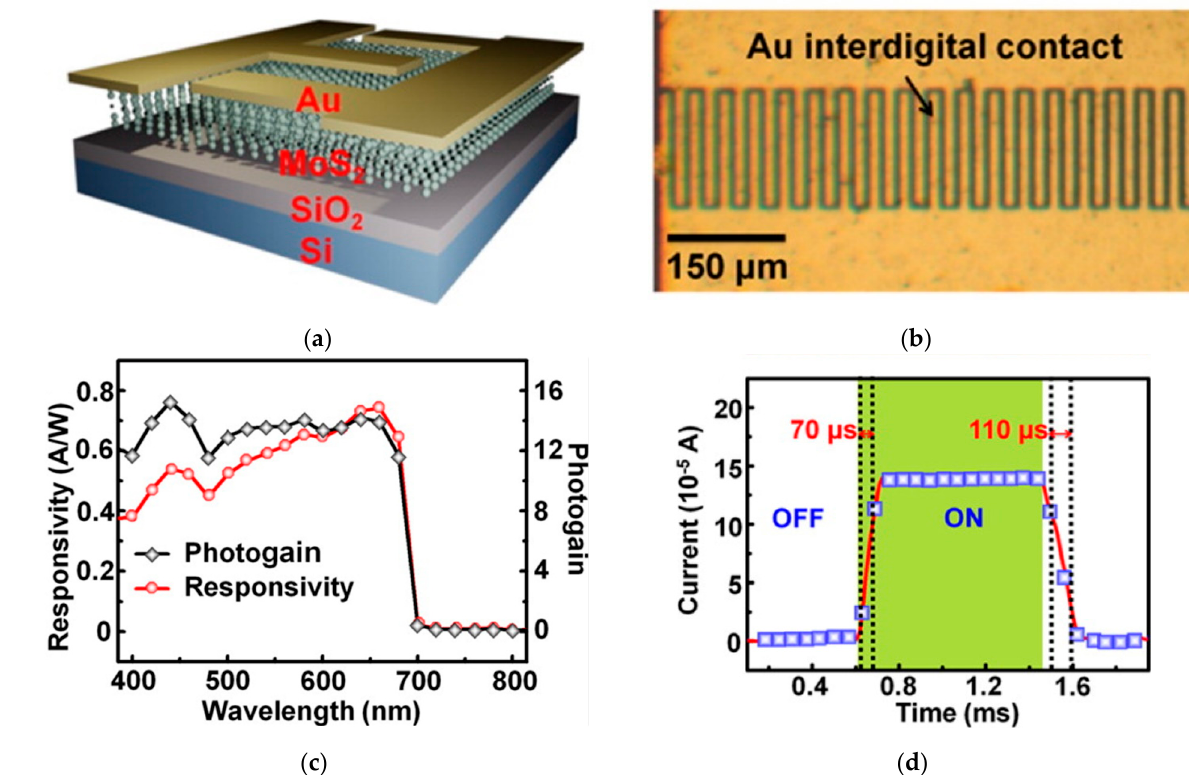
Figure 7. ( a ) Scheme of a photoconductor based on MoS 2 ; ( b ) optical microscope top view of the device, where Au interdigitated contacts are clearly visible; ( c ) responsivity and photogain for the device over the NUV-IR spectral range; ( d ) photoswitching time response of the detector. Reprinted with permission from ref. [50]. © 2013, American Chemical